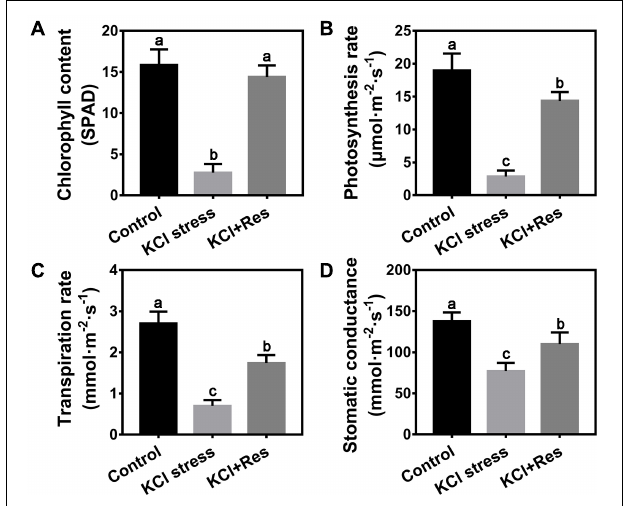
FIGURE 2 | Effects of Res treatment on chlorophyll content (A) , photosynthesis rate (B) , transpiration rate (C) , and stomatic conductance (D) of apple seedlings under KCl stress. The data represent the mean ± SD of biological replicates. Different lowercase letters indicate significant differences according to Fisher’s least significant difference ( P <